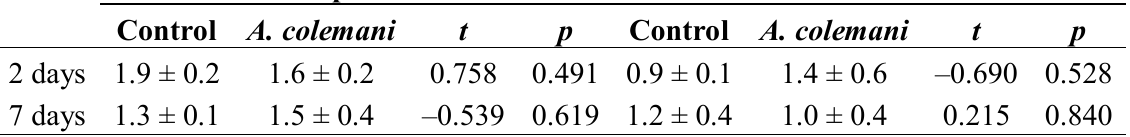
Table 3. Mean ± S.E. values of the displacement ( δ ) of aphids and CMV after 2 and 7 days in arenas with and without (control) parasitoids, followed by statistics according to Student’s t test ( p <